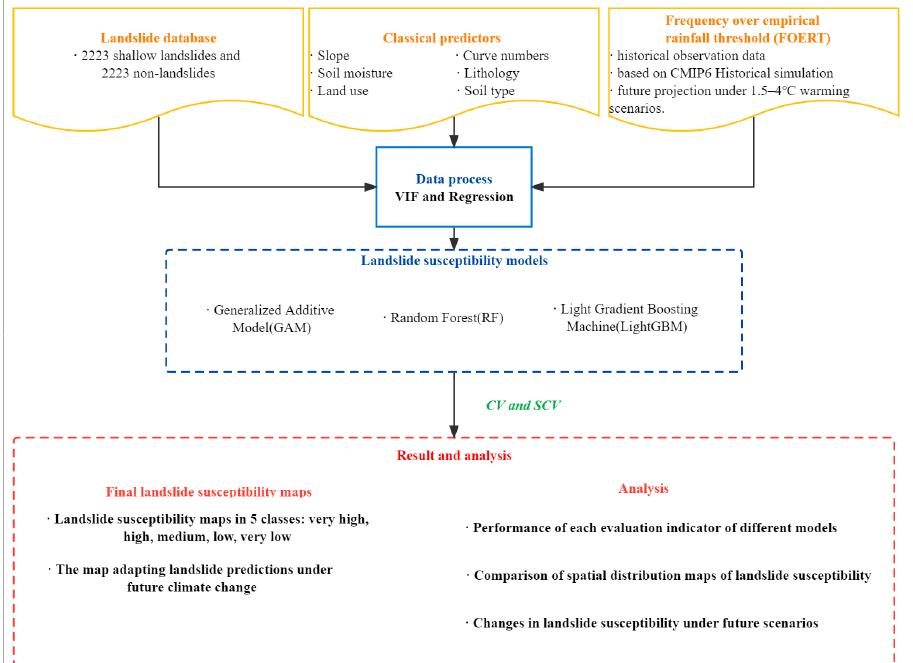
Figure 3. Methodological flowchart of the study .